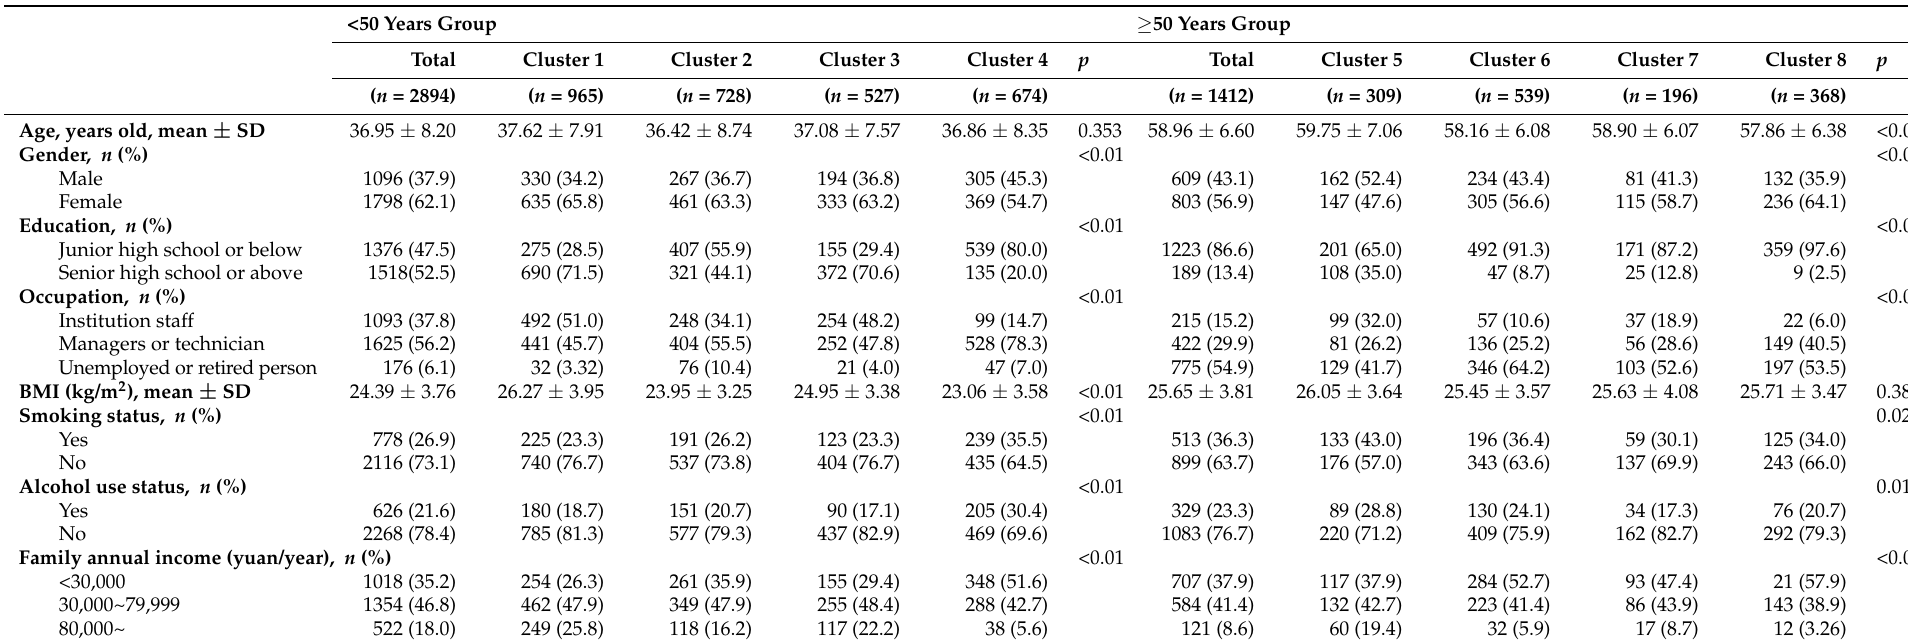
Table 1. Sociodemographic characteristics of different lifestyle behavior